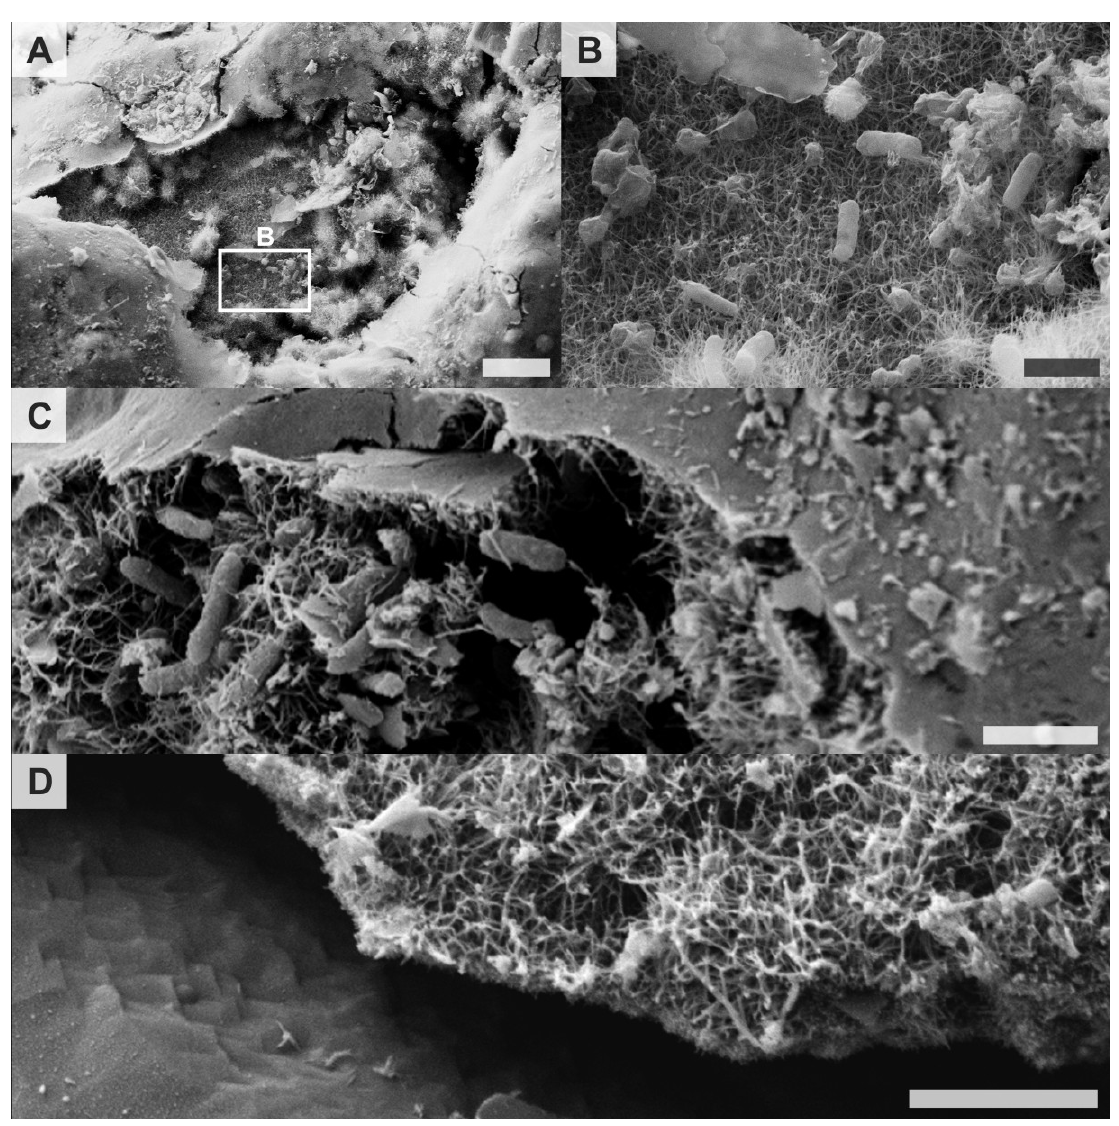
Figure 4. FE-SEM SE micrographs of: ( A ) a exposed region of porous schwertmannite covered by a thin, non-porous crust; ( B ) bacteria within the porous schwertmannite layer observed at higher magnification; ( C ) bacterially-colonized porous schwertmannite beneath the thin, non-porous crust; and ( D ) an area of bacterially-colonized schwertmannite that separated from sulfide-mineral surface revealing extensive pitting. Scale bars equal 10 µm, 1 µm, 1 µm and 1 µm,